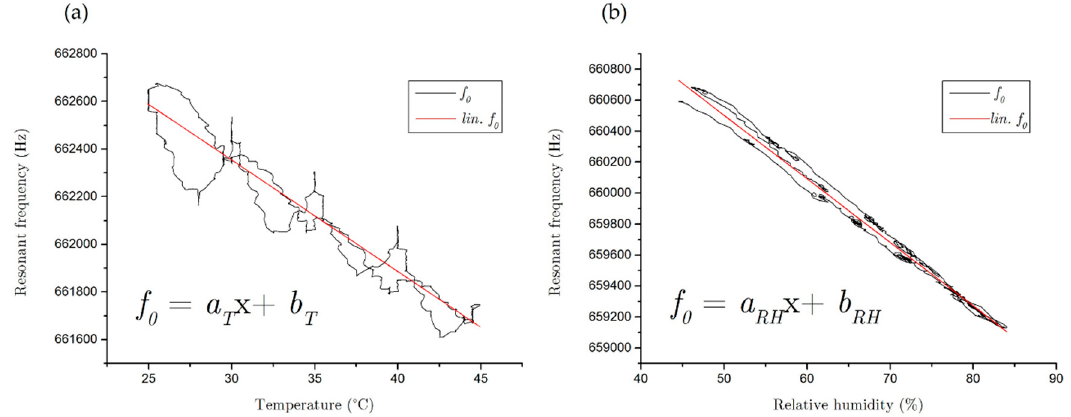
Figure 5. Impact of the temperature ( a ) and humidity ( b ) on the resonant frequency f 0 of a 1 × 1 × 0.1 mm3 microcantilever, with aT = − 47 Hz/°C, bT = 663,759 Hz , aRH = − 41 Hz/%RH and bRH = 662,557